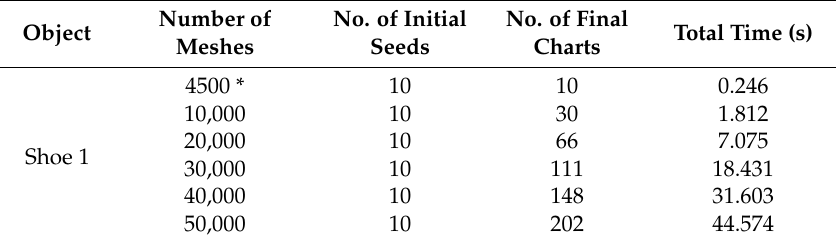
Table 1. Time consuming for mesh